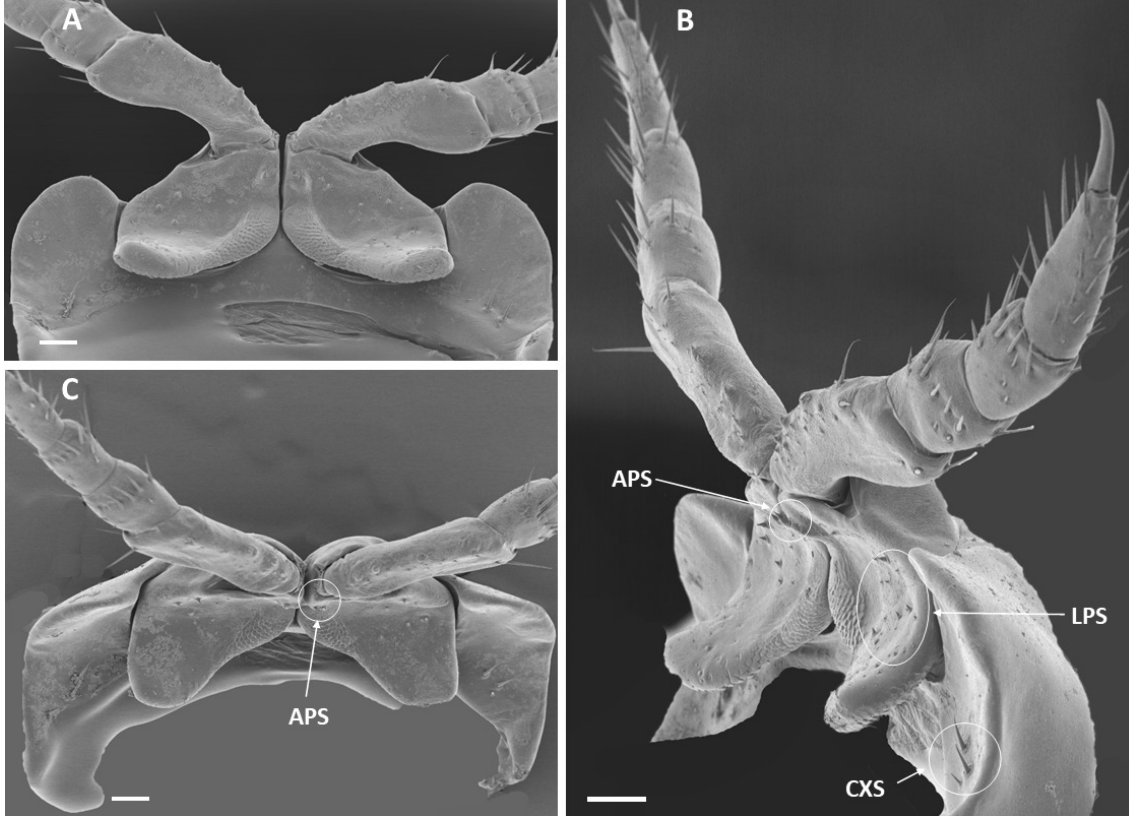
Fig. 7. Antipustia hoteldolichoiuli gen. et sp. nov., paratype, ♂ (NHMD 621700), first pair of legs. A . Anterior view. B . Sublateral view. C . Ventral view. Abbreviations: APS = mesapical prefemoral setae; CXS = coxosternal setae; LPS = lateral prefemoral setae. Scale bars = 0.1